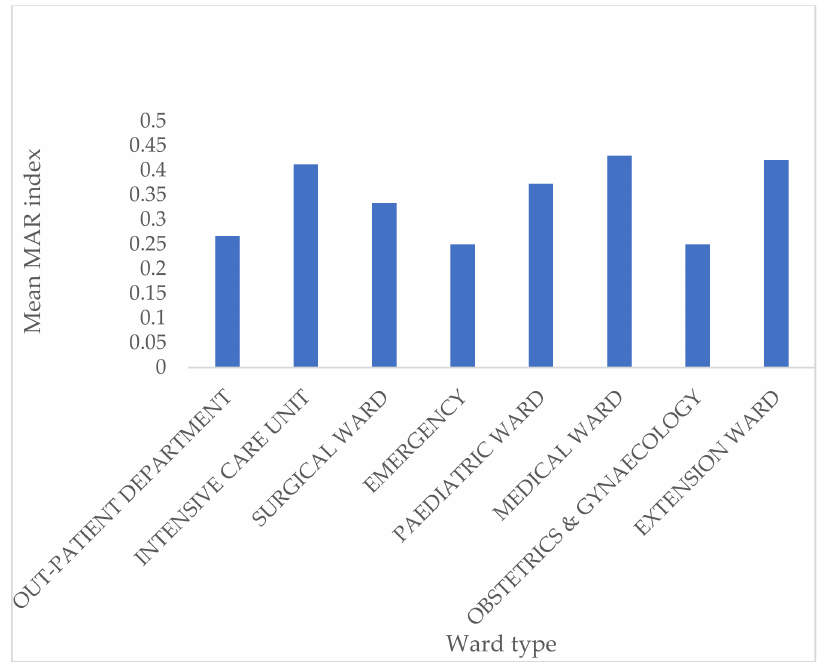
Figure 2. Distribution of MAR index against various ward